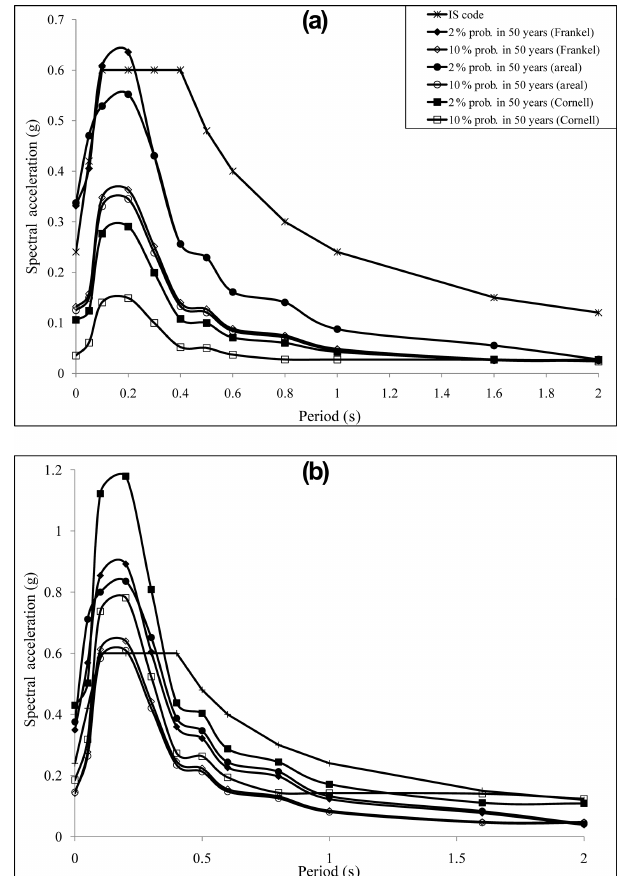
Figure 13. (a) Design spectrum for Patna for 5% damping from 2% and 10% probability of exceedance in 50 years and IS 1893 (2002) at centre of the city (marked in Fig. 11a). (b) Design spectrum for Patna for 5% damping from 2% and 10% probability of ex- ceedance in 50 years and IS 1893 (2002) at the northeastern part of the city (marked in Fig.